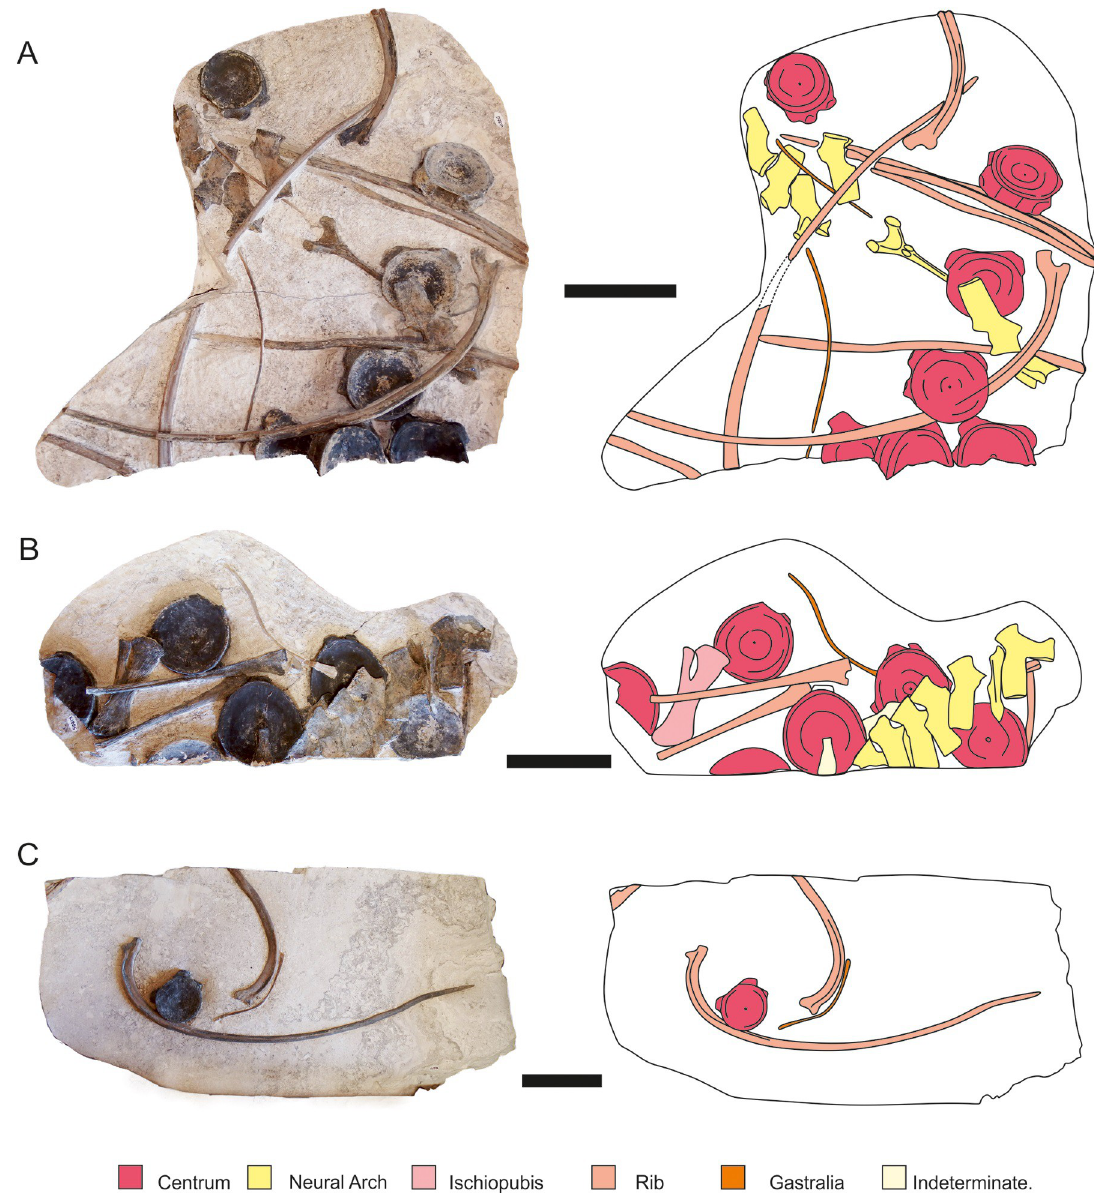
Fig 5. Isolated slabs of Thalassodraco etchesi . A, MJML K1885, B, MJML K1885, C, MJML K1896. Scale represents 100 mm. extending to the external naris; estimated 70 teeth on the upper tooth row � ; extremely short lateral exposure of the maxilla; deep anterior dorsal ribs, approximately 13 times as long as height of vertebral centrum; straight, rod-like distal portion of the clavicle; T- shaped intercla- vicle, with a spoon-shaped posterior ramus with a medial ridge on the anterior portion of pos- terior ramus (but not as spatulate as seen in Grendelius and Undorosaurus ) � ; scapular blade expands distally, giving overall hour-glass outline and proximally expanded with prominent acromion process � ; concave posterior margins of the coracoid, a shallow anterior notch, and is expanded posteroventrally beyond the posterior border of the glenoid; anteromedial process of the coracoid moderately developed and appears to be rounded; medially placed, weakly